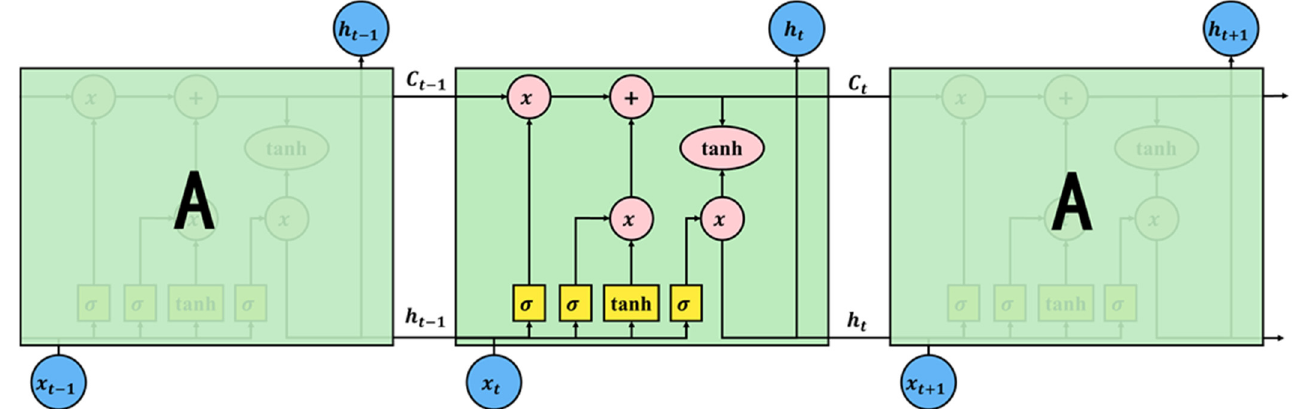
Figure 2. The LSTM structure [27].